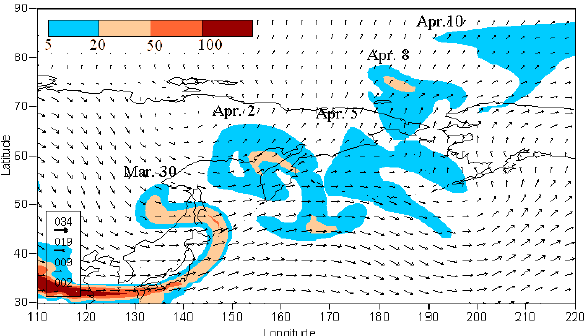
Fig. 3. MEDIA modeled daily lindane air concentration (pg m − 3 ) at about 5200m height on selected days over the period 30 March– 10 April 1997. Figure also shows mean vector winds over the same period and height. The bars at the lower left give wind vectors in knots (Note that 002 mean 2 knots).